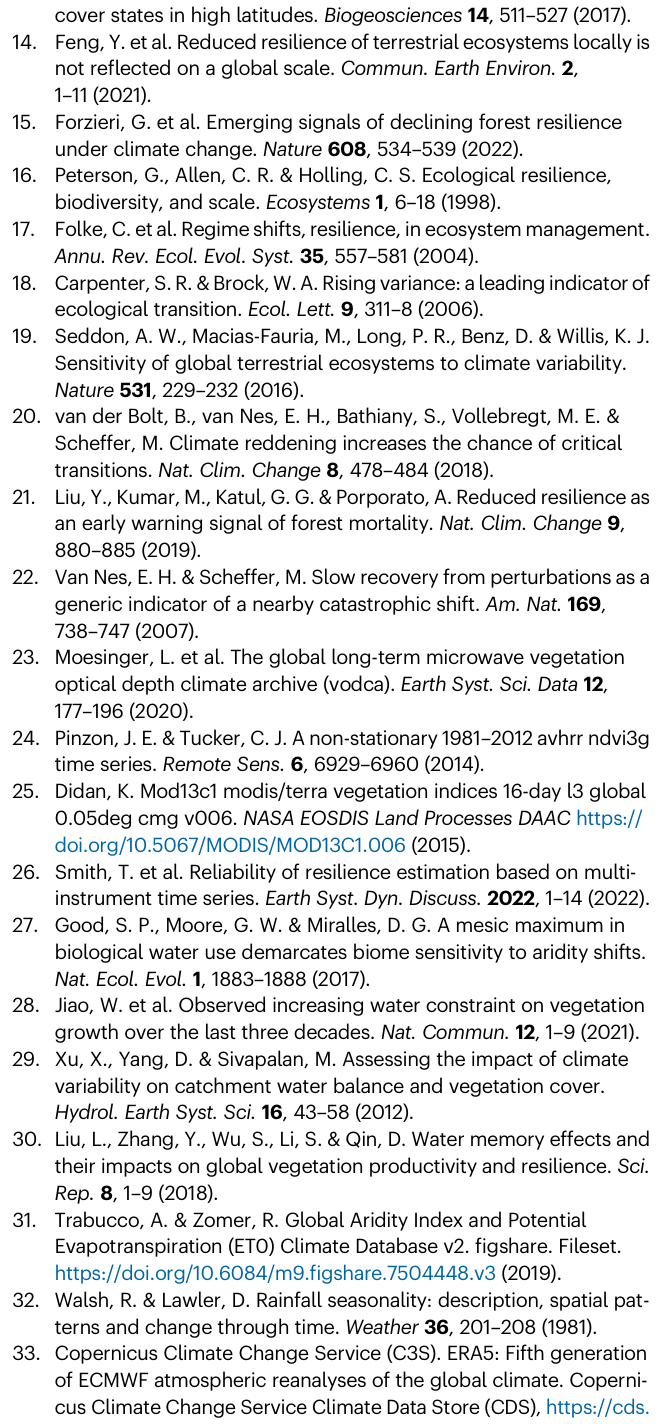
Fig. 5 | Vegetation resilience as a function of normalized inter-annual pre- cipitation variability (Methods), separated by land-cover type 46 . Vegetation resilience λ estimatedempirically( A , B )andviatheAC1( C , D )forvegetationoptical depth (VOD, left column) and MODIS NDVI (right column).Binned medians shown assoliddots(Kendall-Tau(KT) p <0.05)andtransparentarrows(KT p >0.05),with 25 – 75th percentiles of each bin shown as connected vertical lines capped with hatches. Land covers with less than 1000 points or less than 10 bins of at least 50 members are omitted. E KT coef fi cients (aridity vs AC1-derived λ , panels C , D ) for each land-cover type. Signi fi cant ( p <0.05) KTs shown as a black triangle (KT of